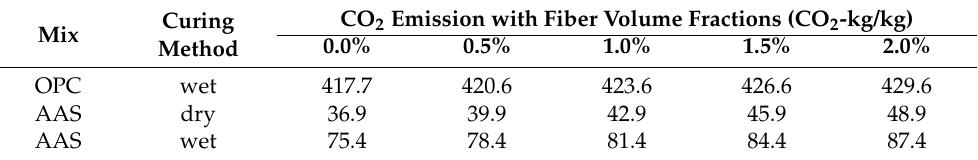
Table 8. Final CO 2 emission of concrete with fiber inclusion.